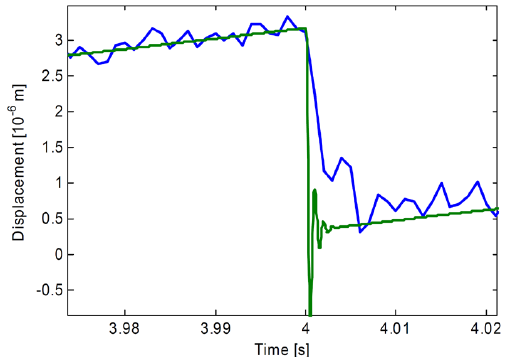
Figure 22. Scaled up picture from Fig. 21 (at around the 4th sec-